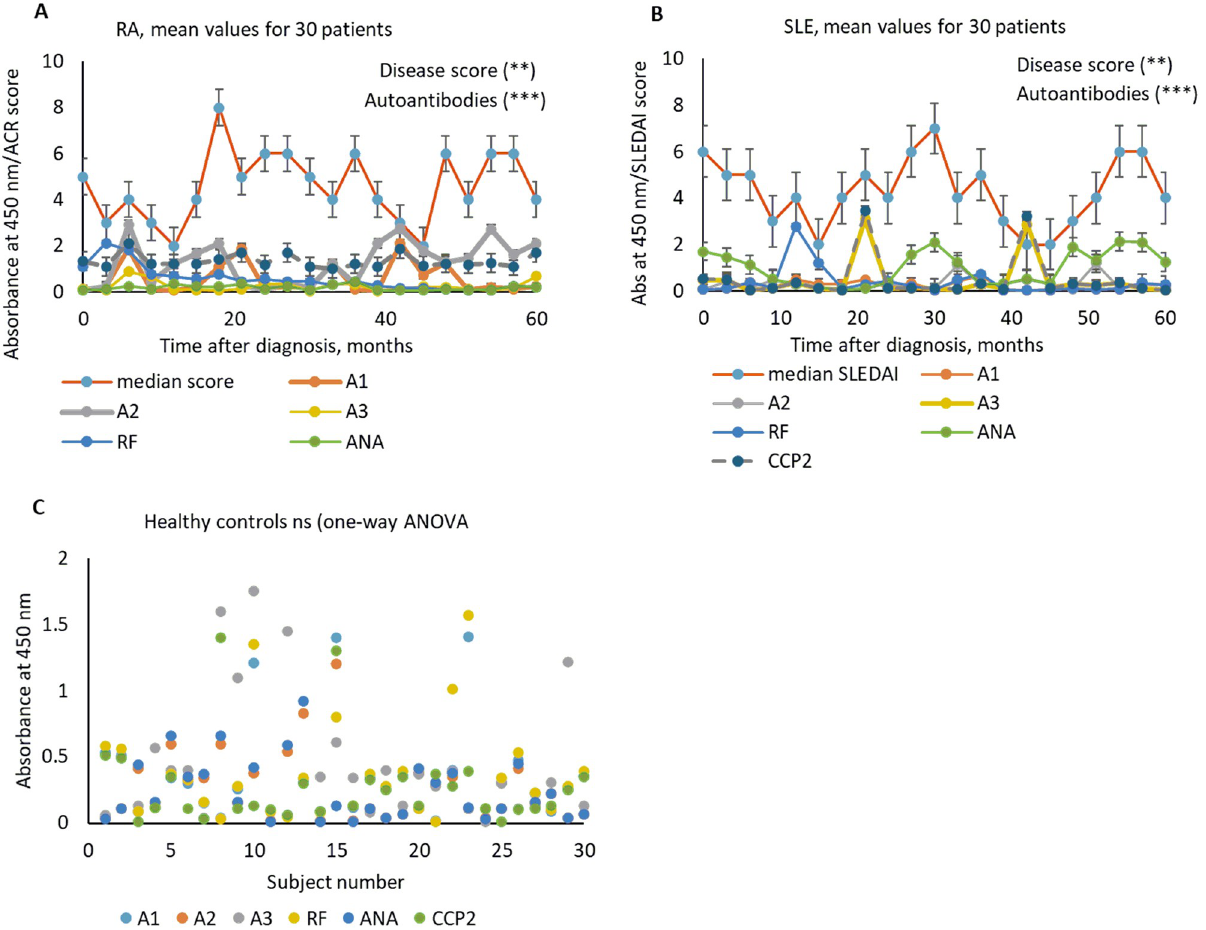
Fig 3. Longitudinal study of patients across a set of antigens: RA (A), SLE (B) and healthy controls (C).